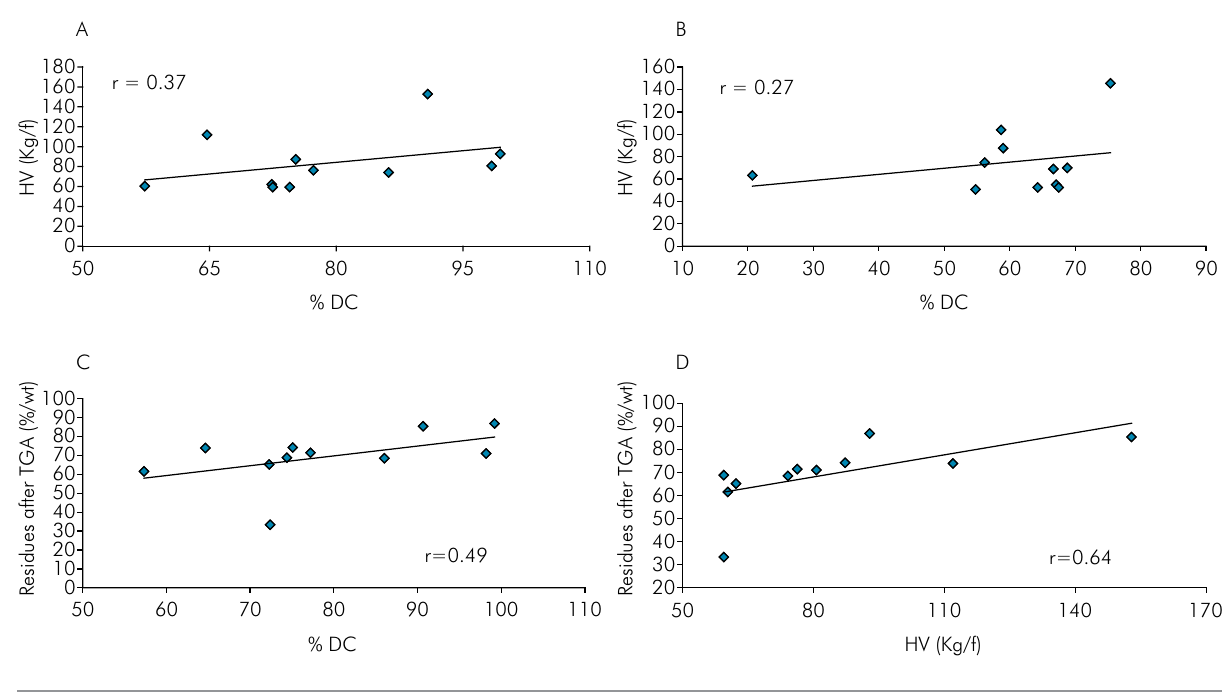
Figure 2. Correlation between degree of conversion and Vickers microhardness, considering the polymerized side: top (A) and bottom (B); between the % of residues, in weight, of the polymerized sample after TGA, and the degree of conversion (C) and microhardness (D).